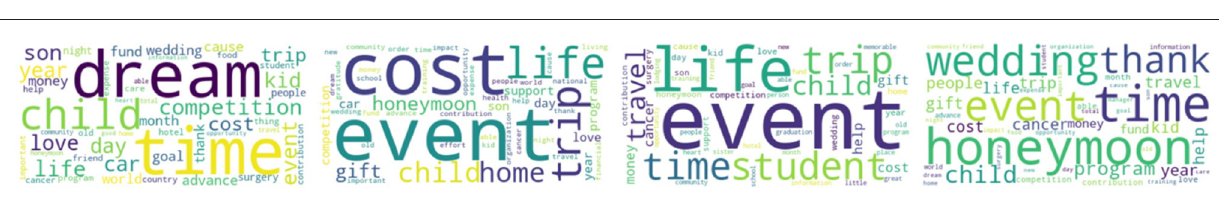
their success: the longer a project lasts, the more likely people are to find and share it ( p < 0.001). Campaigns with a greater number of shares typically receive more donations ( p <